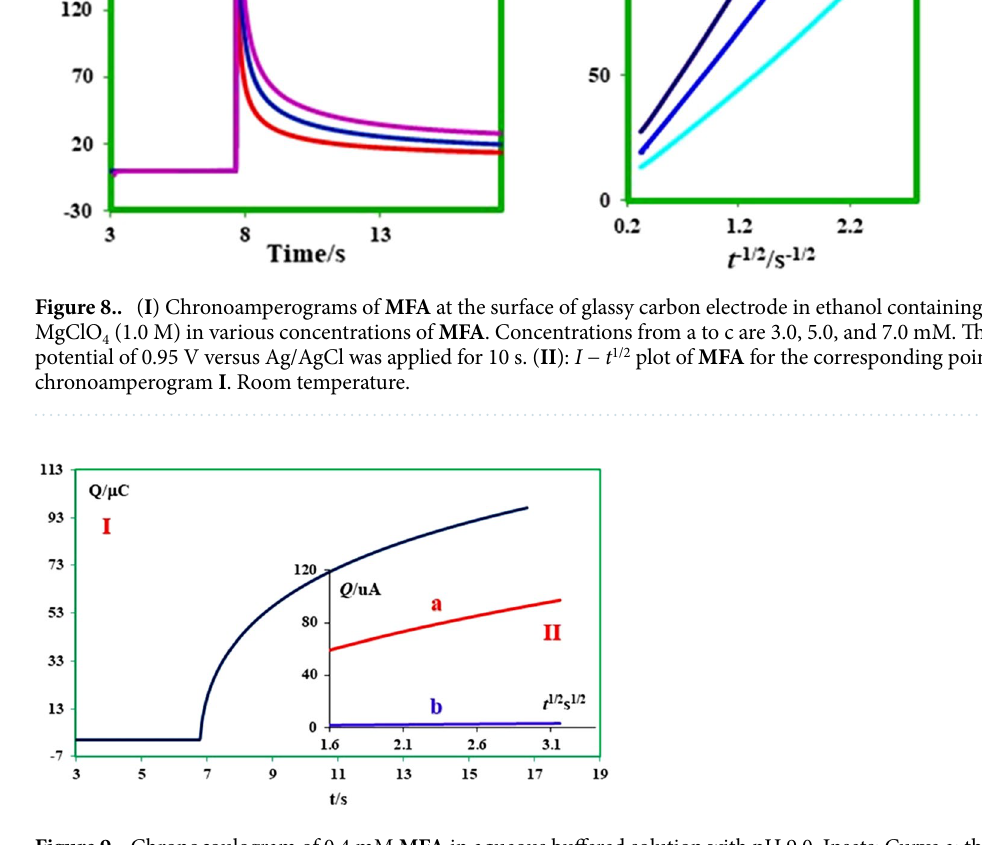
Figure 9. Chronocoulogram of 0.4 mM MFA in aqueous buffered solution with pH 9.0. Insets: Curve a: the plot of the total charge ( Q total ) vs. t 1/2 of MFA (0.4 mM), Curve b: the curve of the total charge ( Q total ) vs. t 1/2 of a solution with supporting electrolyte in the absence of MFA at the same